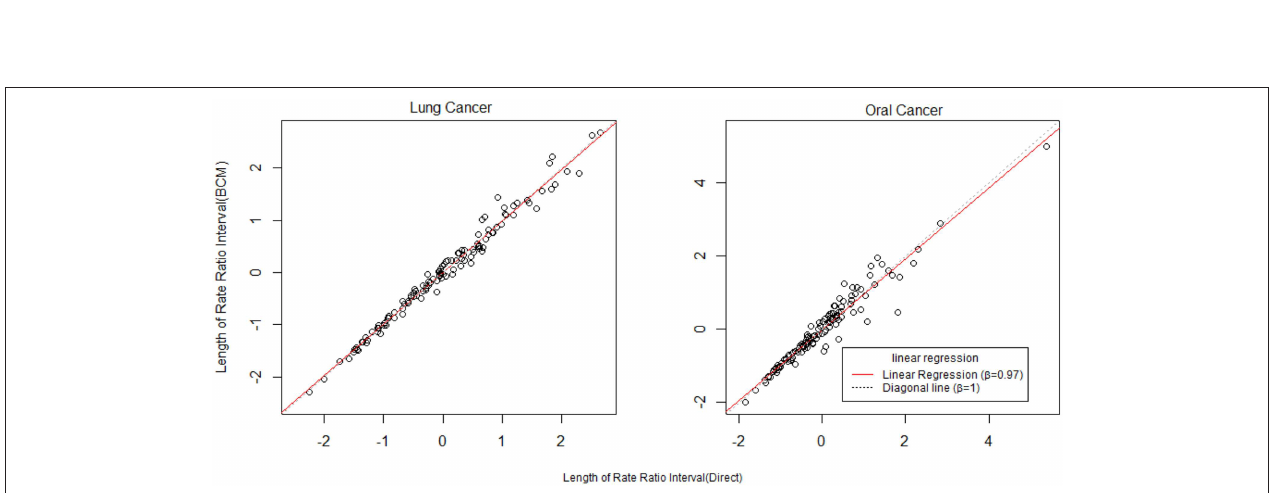
FIGURE 5 | The comparison of rate ratio interval length between Direct method and BCM model (Before standardization). β is the slope for regression and ρ is the bivariate correlation.